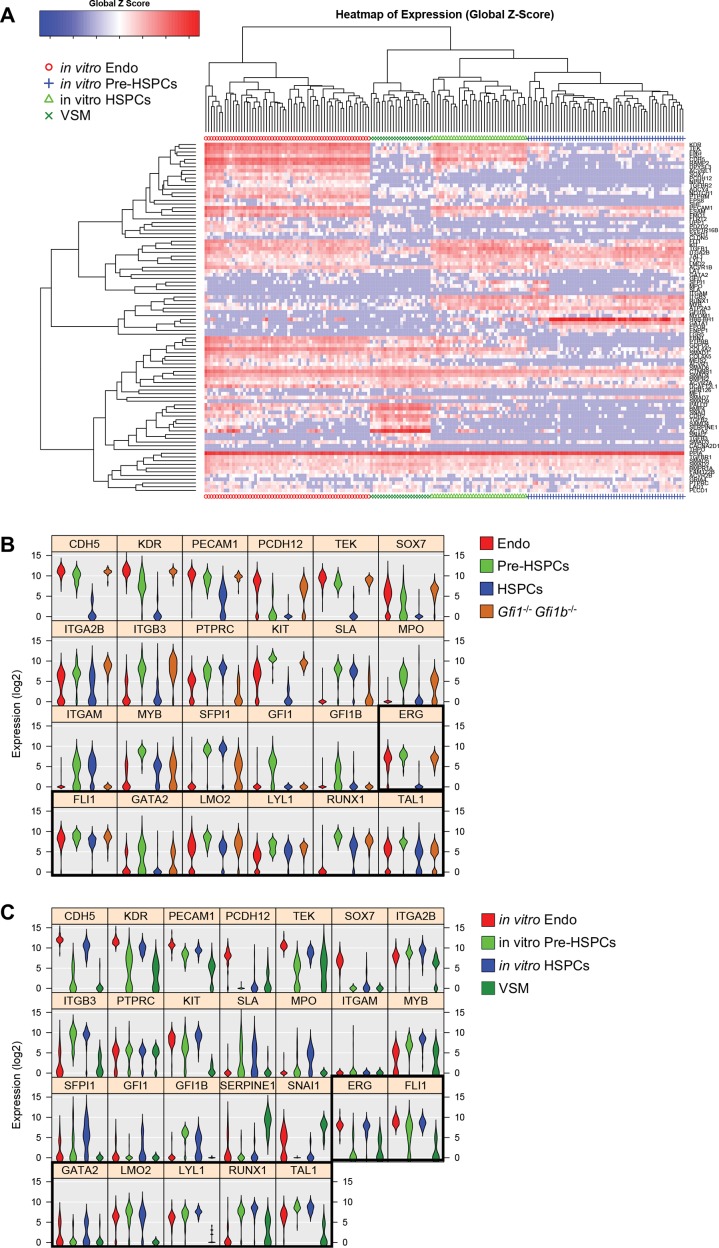
Hierarchical clustering analysis of in vitro differentiated ESCs.(A) Hierarchical clustering analysis done with sc-q-RT-PCR data from in vitro differentiated ESCs. Four main clusters were defined. (B) Violin plots showing the expression of the 24 genes shown in Figure 1E. Seven key transcription factors are highlighted with a black rectangle. (C) Violin plots showing the expression of the 26 genes shown in Figure 1F. Seven key transcription factors are highlighted with a black rectangle. See also Supplementary file 11.